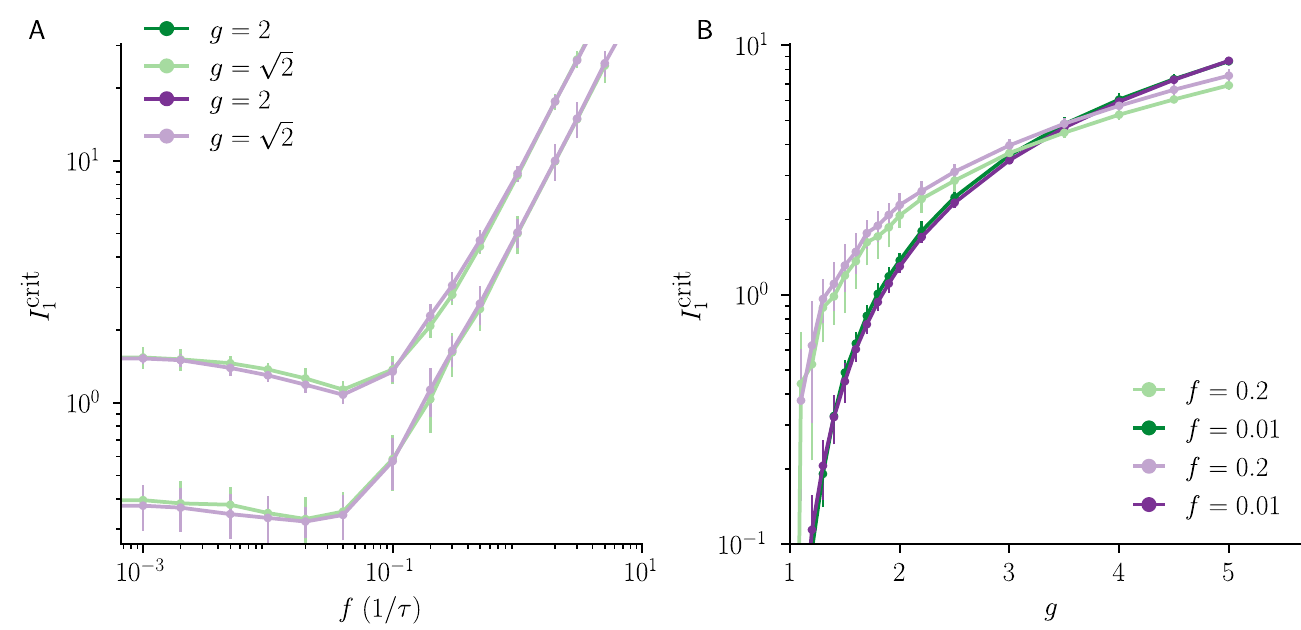
Fig 10. No qualitative difference in chaos suppression by common vs independent input in canonical random networks. A) I crit ffiffiffi p frequency f ( g ¼ 2 light color, g = 2 dark color). I crit has a minimum for both common and independent input. The independent input case is identical to the 1 scenario studied in [3]. At high f , the low-pass filter effect of the leak term attenuates the external input for both cases, thus resulting in a linearly increasing I crit on the gain parameter g for both low input frequency ( f = 0.01/ τ , dark color) and high input frequency ( f = 0.2/ τ , light color), showing a Dependence of I crit ffiffiffi p 1 monotonic increase. Error bars indicate ± 2 std. Model parameters: N = 5000, g 2 f 2 ; 2 }, f 2 {0.01, 0.2}/ τ , I 0 = J 0 = 0.